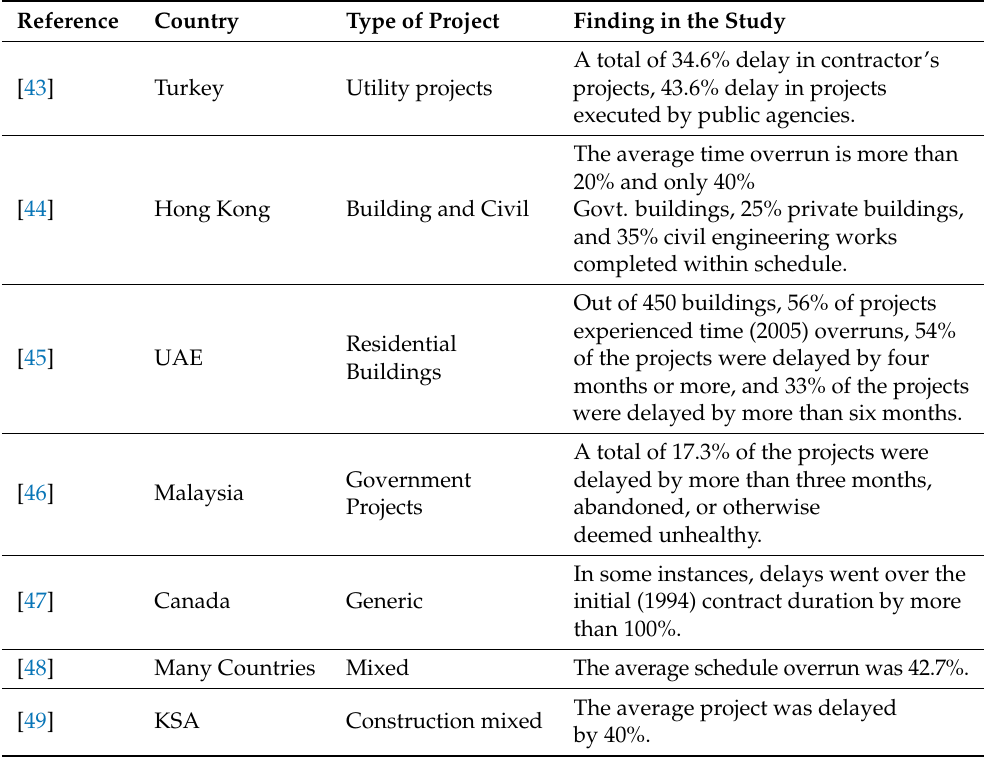
Table 2. The magnitude of building project delays as reported by earlier studies